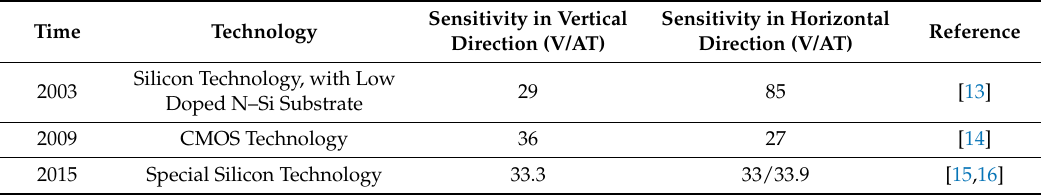
Table 4. Performances of the single-device 3D Hall sensors based on different